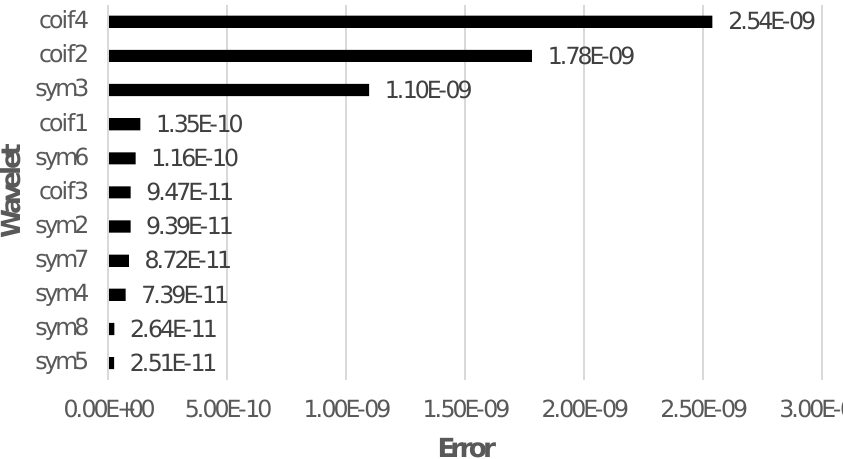
Figure 1. RMSE for the reconstructed signals using all the coefficients of different wavelets.